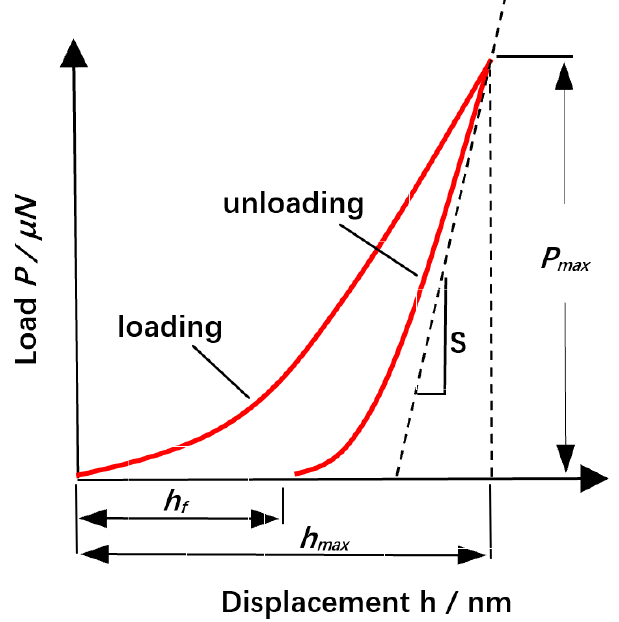
Figure 1. Typical crystal load–displacement curve.